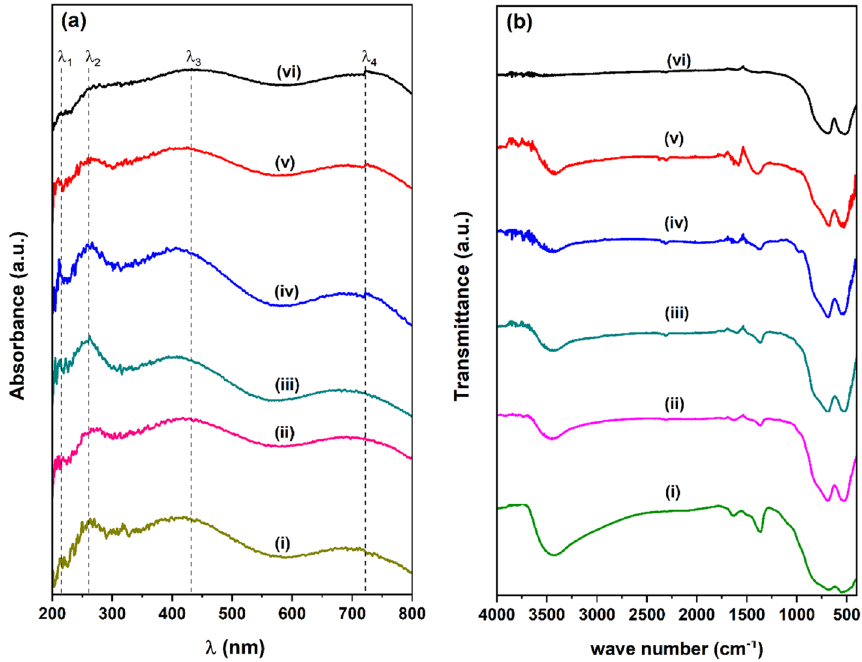
Figure 3. ( a ) UV–Vis spectral analysis of (i) 15Co/600MA (ii) 15Co/700MA (iii) 10Co/800MA (iv) 15Co/800MA (v) 20Co/800MA, and (vi) 15Co/900MA catalysts. ( b ) FTIR spectral analysis of (i) 15Co/600MA (ii) 15Co/700MA (iii) 10Co/800MA (iv) 15Co/800MA (v) 20Co/800MA, and (vi) 15Co/900MA